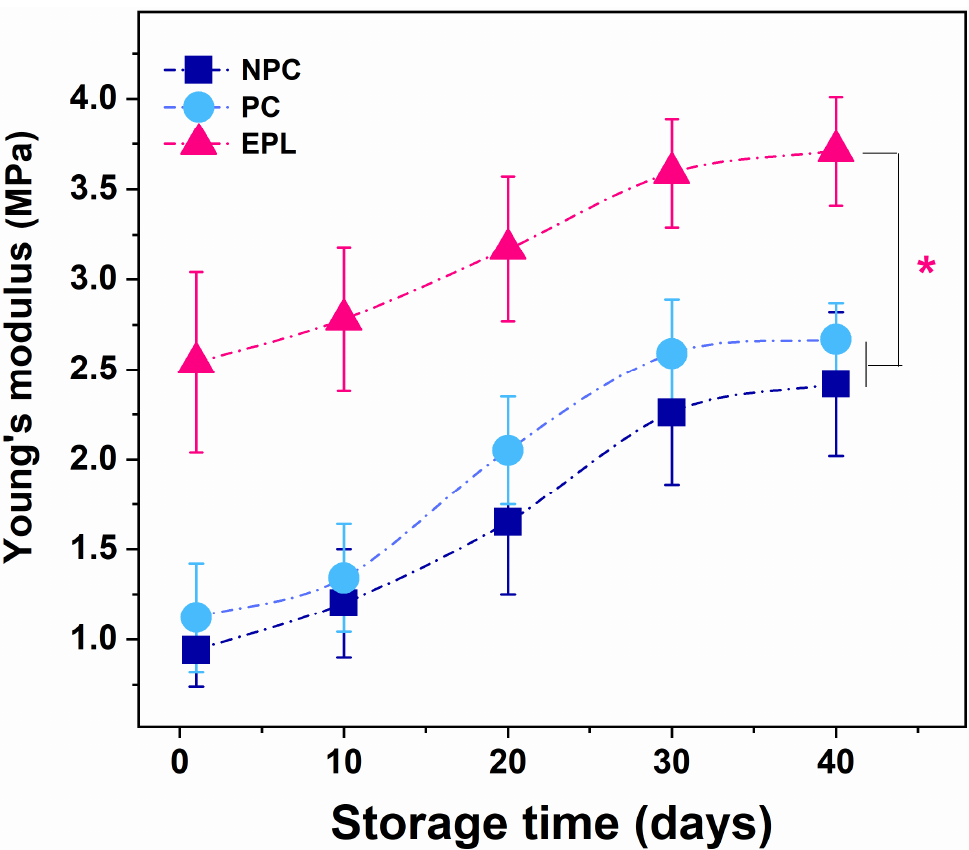
Figure 6. Young’s modulus values of erythrocytes aging recorded on the 1st, 10th, 20th 30th, and 40th isolate from nonpregnant controls (NPC), pregnant controls (PC), and women with early pregnancy loss (EPL). Non-parametric Wilcoxon test was used to determine statistical differences, which are given as p values, indicated as * p < 0.01 relative to both NPC and